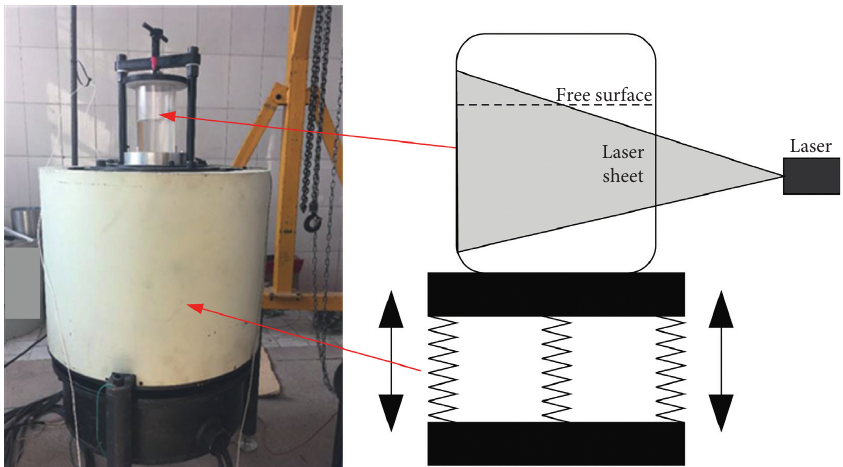
Figure 3: Schematic representation of the resonant acoustic mixer (left) and the PIV system (right).